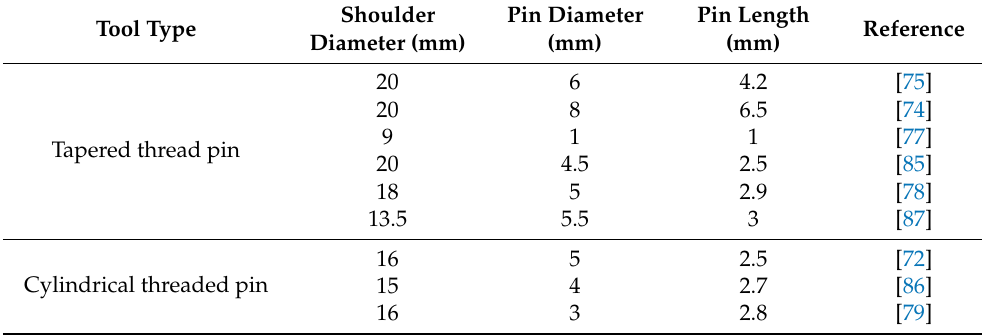
Table 4. Welding tools used in the literature during conventional FSW of metals to polymers. Tool